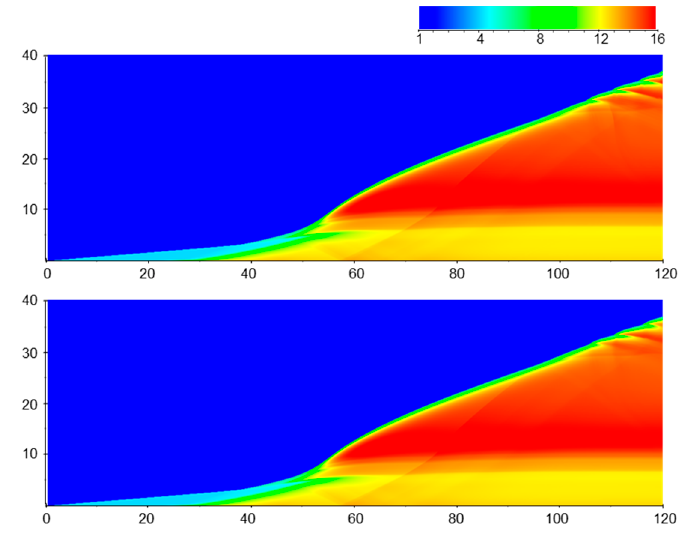
Figure 6. Temperature contours for the case M 0 = 10.0, θ = 30° and k R = 2.8 using the two-step induction-reaction kinetics and CFL number equal to 0.5 (upper); and 0.25 (lower).